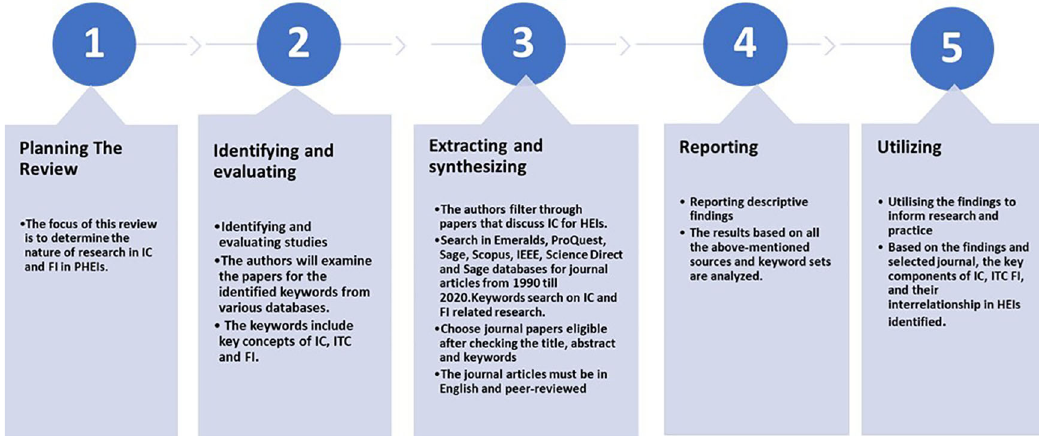
Figure 1. Five stages of systematic literature review.